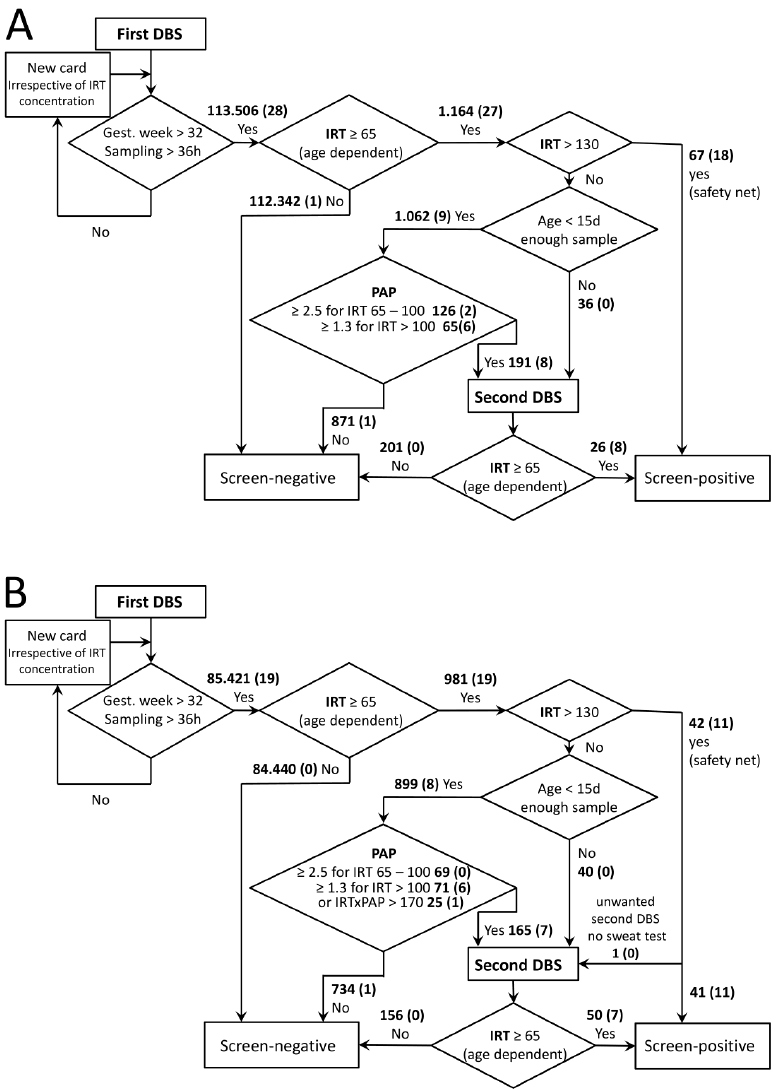
Figure 1. CF Screening schemes in Austria. Algorithms for the first period ( A ) and the second period ( B ) are depicted. Bold numbers give numbers of cards within indicated categories. The number in brackets is the number of confirmed positives within these categories. IRT and PAP cut-off concentrations are given in ng/mL, IRT × PAP in ng 2 /mL 2 .